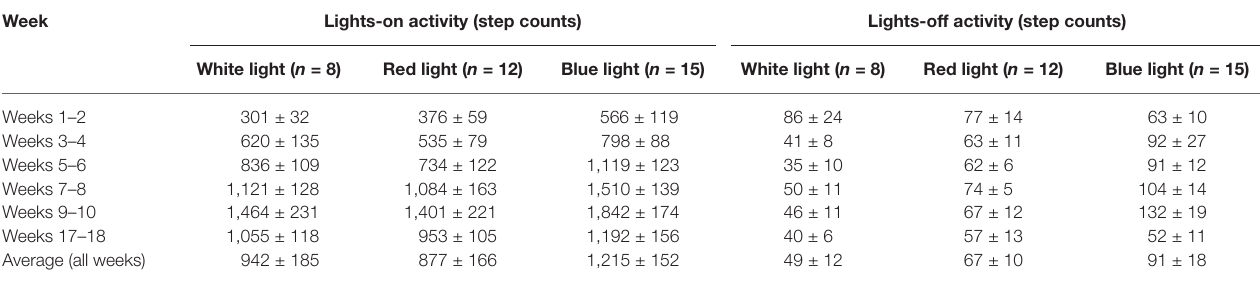
TABLE 1 | Average 12-h lights-on (7 AM–7 PM) and lights-off (7 PM–7 AM) activity (step counts) for white, red, and blue light reared monkeys by 2-week